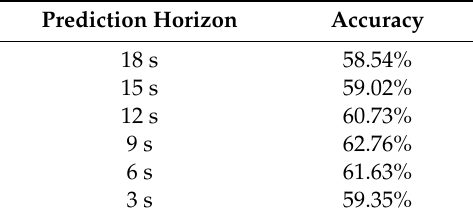
Table 3. Prediction accuracy of decision